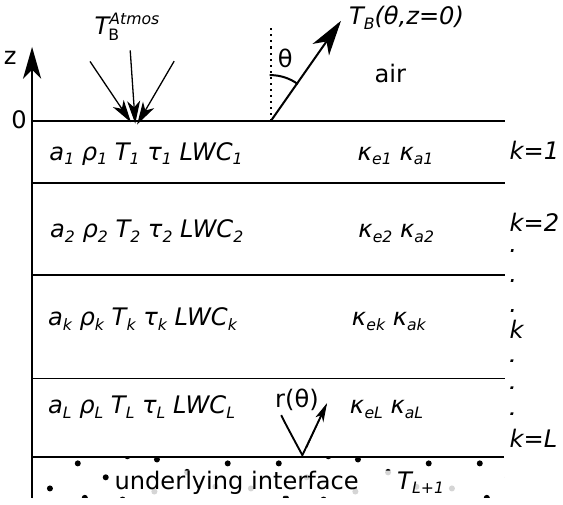
Fig. 1. The snowpack viewed by DMRT-ML. L is the number of layers. For each homogeneous layer k , the input variables and pa- rameters are grain size a k , snow density ρ k , physical temperature T k , stickiness τ k and liquid water content LWC k . The extinction and absorption coefficients κ e and κ a are calculated with the DMRT- ML theory. The boundary conditions require the input of the down- welling brightness temperature T atmos and the variables and param- B eters to compute the reflection coefficient r(θ) of the underlying interface (see Table 1). The DISORT method is used to solve the ra- diative transfer equation in the snowpack and provides as output the brightness temperature T B (θ,z = 0 ) emerging from the